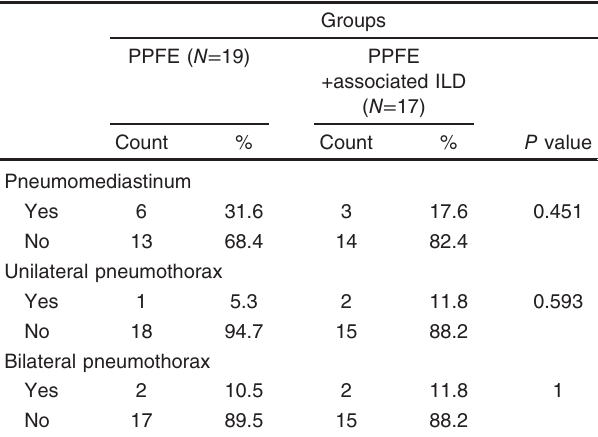
Table 2 Pneumothorax and pneumomediastinum among the pleuropulmonary fibroelastosis subgroups